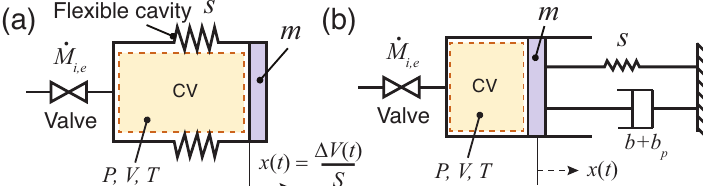
Figure 1. Proposed thermal actuator ( a ) schematic sketch and ( b ) lumped model. CV denotes the cavity or control volume with state parameters: pressure P , volume V , and temperature T at time t . The valve on the left is used for the intake or exhaust of the working fluid (air). The valve is connected to the ambient atmosphere ( P o , T o ) during the intake and exhaust processes. For the closed cycle, the valve remains closed over the entire operating